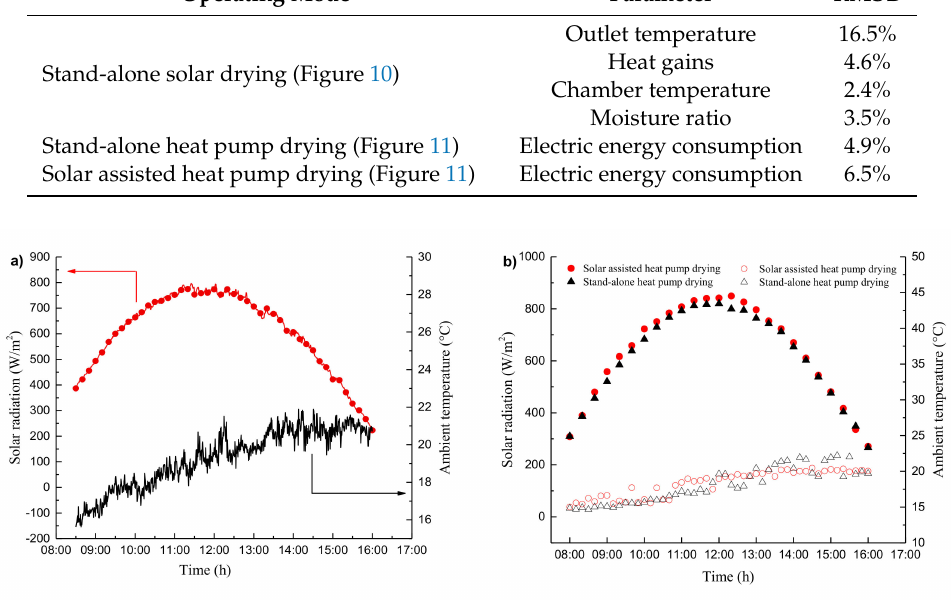
Figure 9. Weather data of the stand-alone solar drying ( a ) and the stand-alone heat pump and the solar assisted heat pump drying ( b ).